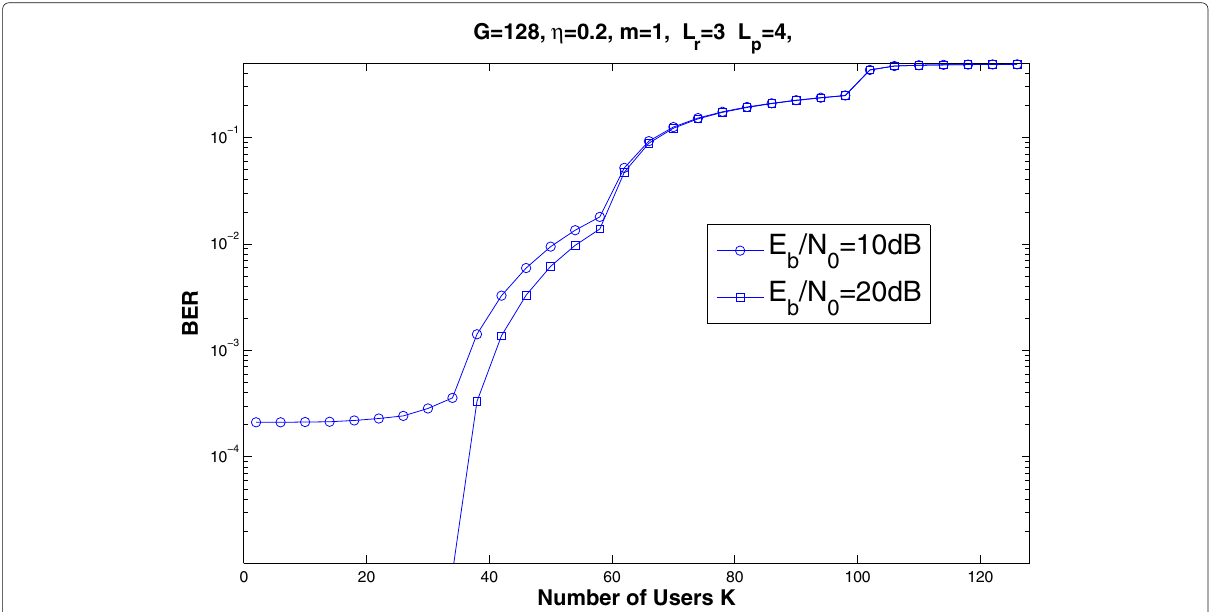
Fig. 8 BER performance vs. the number of supported users K in a